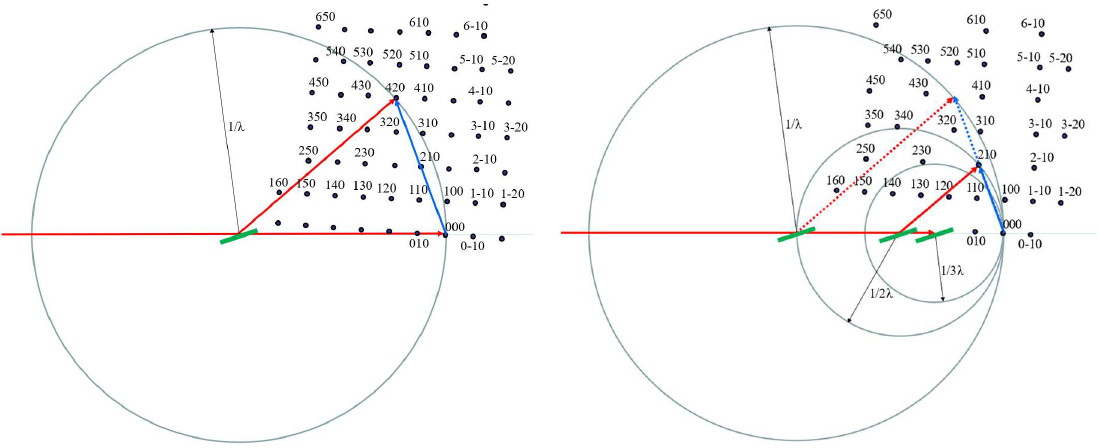
Figure 8. ( a ) Conventional Ewald sphere with a pathlength difference of one wavelength λ . ( b ) Ewald spheres based on pathlength differences of multiple wavelengths. The nested spheres in ( b ) only require the fundamental lengths to exist, e.g., d 210 , which avoids the situation in ( a ) where there may not be any atoms on planes separated by certain lengths, e.g., d 420 , making it confusing to visualise the diffraction process.